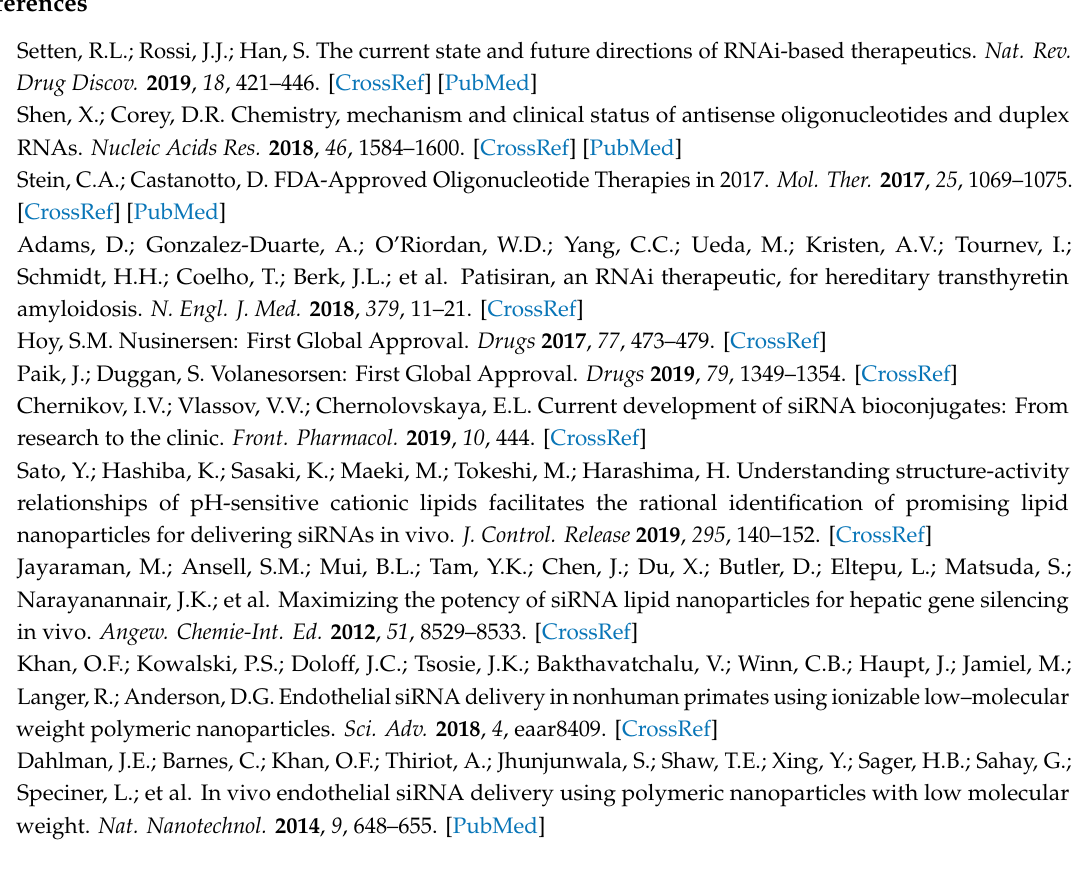
Figure S1: HPLC profiles of